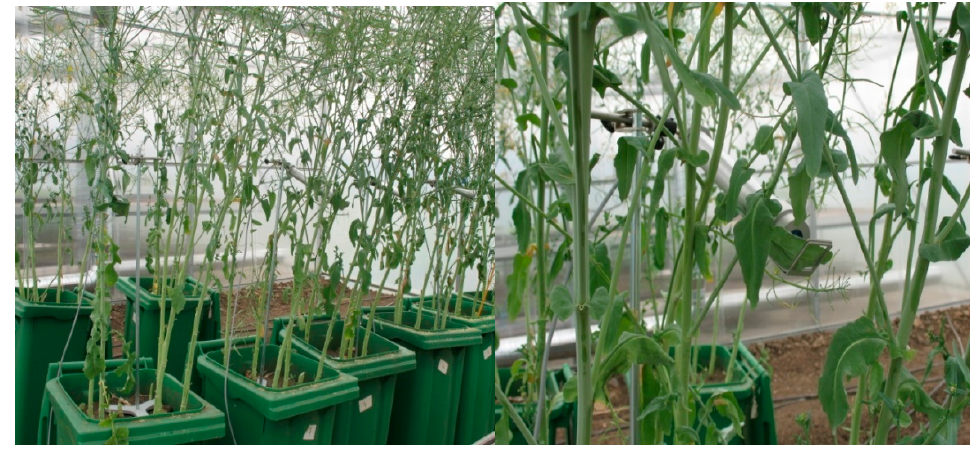
Figure 25. Example of visualization of sensor records for one day (external air temperature).